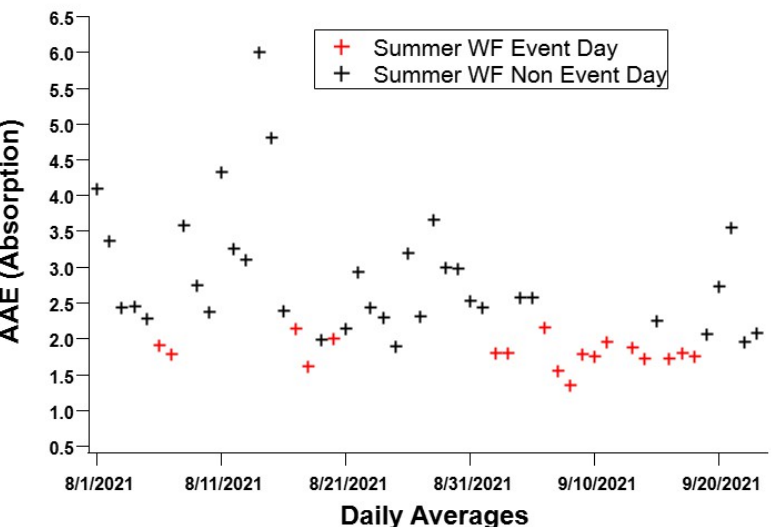
Figure 11. The Absorption Ångstrom Exponent was calculated using the Babs as calculated by the PAX instruments at 405 nm and 870 nm. The black markings correspond to the daily averages of the days where no wildfire smoke arrived at the region and therefore represent the AAE for the baseline. The red markings indicate the daily averages for the days when wildfire smoke was detected in the region—event days—(eighteen event days between August and September of 2021). The baseline AAE was not subtracted from the event days AAE, hence the red markings indicate the AAE for the event days plus the background AAE.